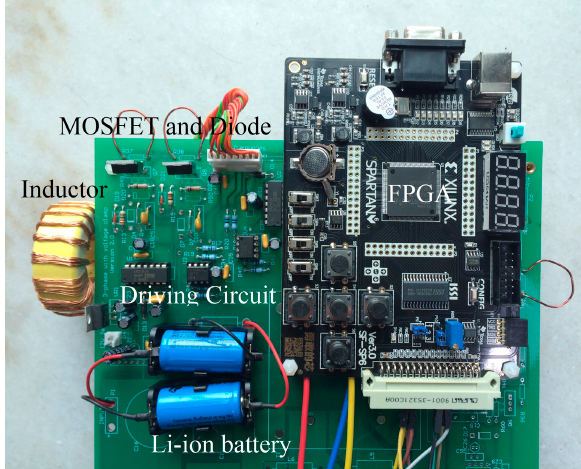
Figure 10. The picture of the experimental setup.